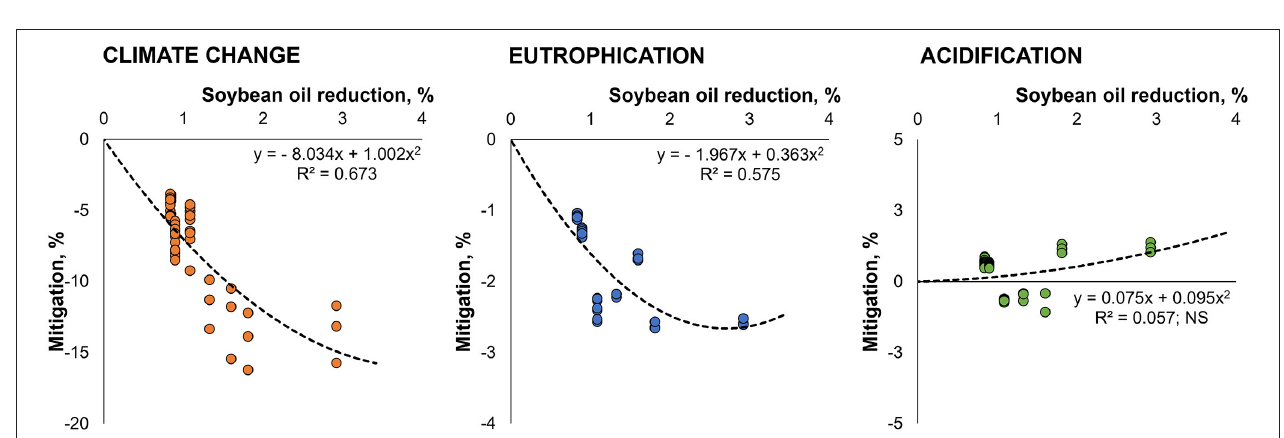
FIGURE 5 | Potential environmental impact mitigation associated with the production of pig and broiler feeds due to soybean oil reduction through energy savings released by β -mannanase supplementation. For this regression analysis, species was not significant ( P > 0.05) in the model. In addition, for the acidification impact, all terms were not significant in the regression